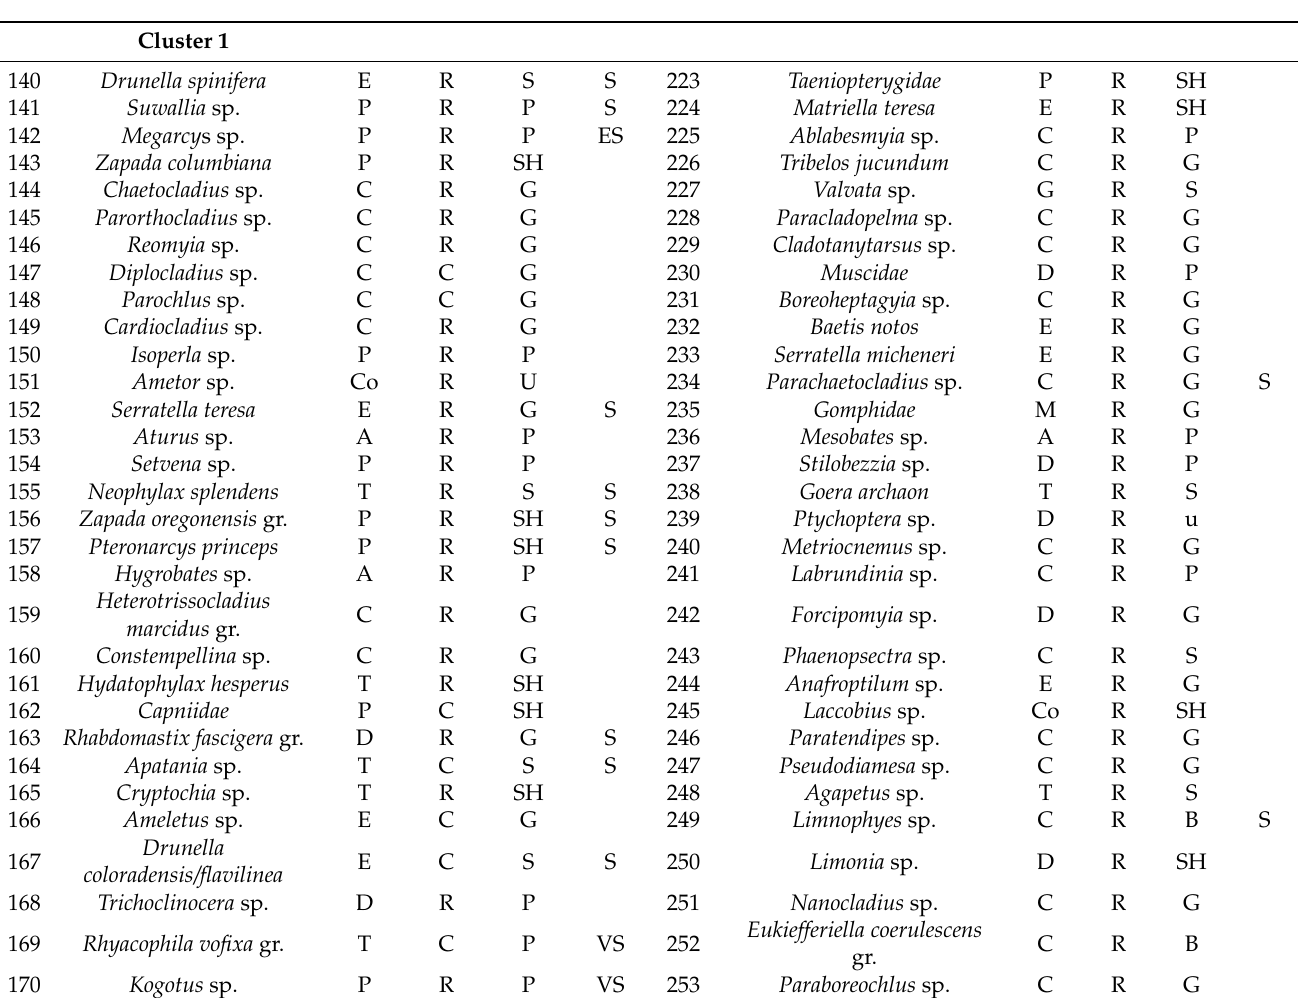
VS 253 Paraboreochlus sp. C R G Macroinvertebrate assemblages along the Y-axis divide into three broad clusters that generally aligned with our disturbance intensity categories (Figure 8). Reaches/years sepa- rate the L cluster in two clusters generally distinct from the H and D group (Figure 8a–d). All D reaches are at the top of the figure (except for 2016 samples) split from L and H reaches (Figure 8a–d). The larger cluster contained three discernible sub-clusters: first the larger contributing area high flood reaches, H3 and H1, separated from the smaller